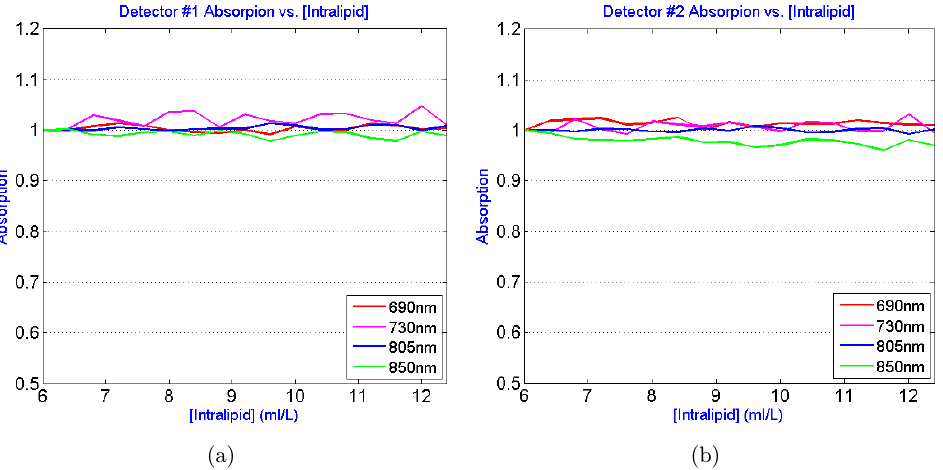
Fig. 5. Reconstructed value of absorption for linear increasing of intralipid r (a) at detector #1 location, and (b) at detector #2 location.